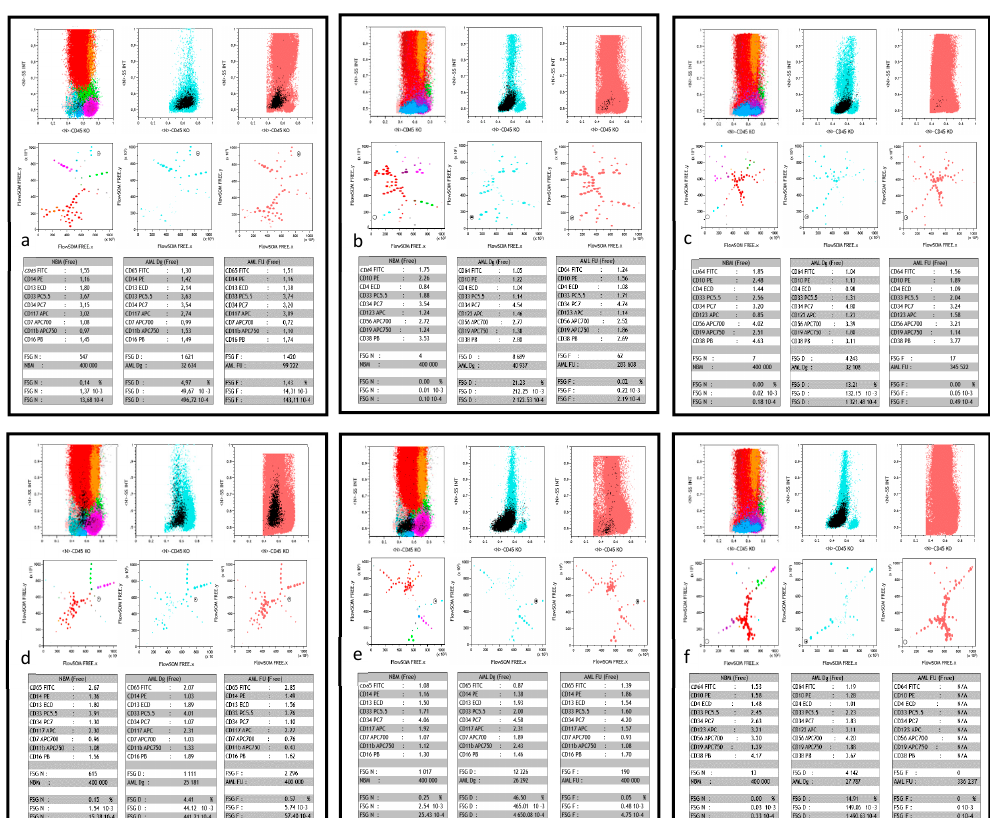
Figure 1. Typical FlowSOM/Kaluza displays. This figure shows, for 6 different patients ( a – f ), part of the comparative dashboard allowing for the supervised search of MRD after FlowSOM unsupervised process, in the Kaluza software environment. For each case, the first three plots in the upper row are the respective CD45/SSC biparametric histograms of merged normal bone marrow (NBM), AML patient diagnosis (AML Dg) and follow-up (AML FU). As previously de- scribed [15], color codes show the major sub-populations of NBM, all AML Dg cells (powder blue) and all AML FU cells (powder pink). The black color is used to single out the FlowSOM node of interest and thus highlights its backgating on the three CD45/SSC graphs during supervision. The three plots in the middle row display the FREE-FlowSOM MSTs generated as described in the method section, again focused on NBM, AML Dg or AML FU. The same color precedence is used, in particular the black color for the FlowSOM node of interest during supervision. The lower row shows the respec- tive statistical tables corresponding to the characteristics of the black supervised node in NBM, AML Dg and AML FU. Each table displays the normalized MFI ratio of the 9 markers of interest, number of events analyzed, and node events (count, 10 − 2 (%), 10 − 3 or 10 − 4 ). ( a ) patient #37 is a true positive (TP, i.e., both molecular and flow MRD) case of MRD > 10 − 3 ; in tube 1, the supervised FlowSOM AML FU node represents a residual minor clone (1.25% in AML FU vs. 4.97% of cells at diagnosis), however 10 times more abundant than in NBM. ( b ) patient #33 is another TP case of high sensitivity